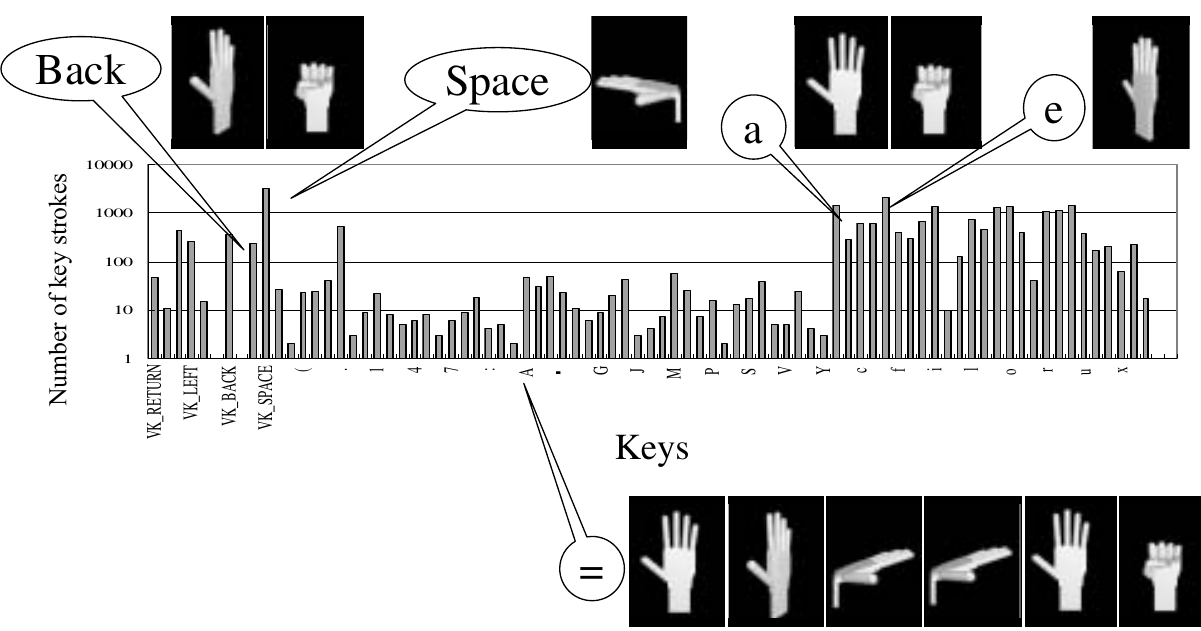
Figure 10 Keystroke occurrences and the Huffman code tree.